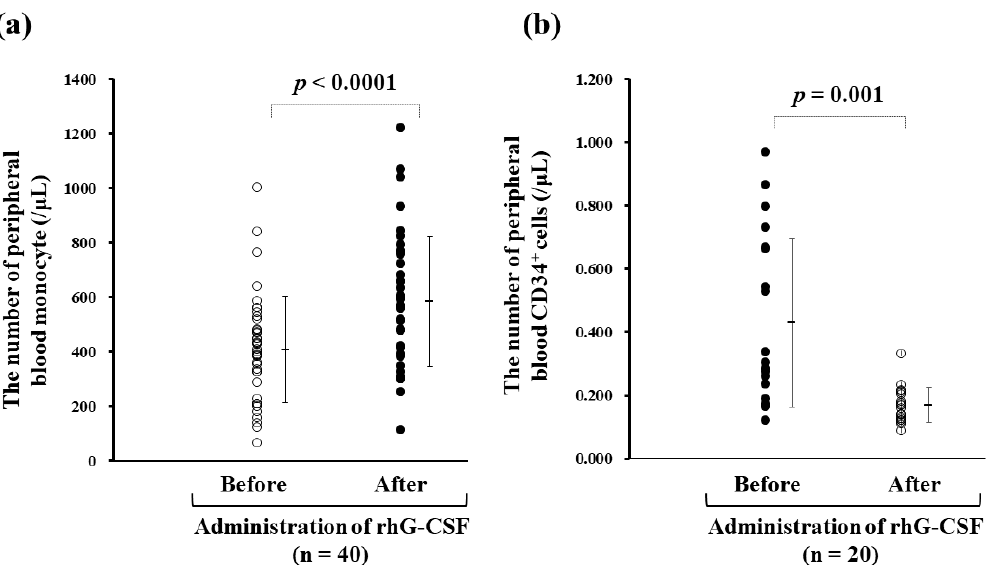
Figure 4. Correlation between peripheral blood monocyte counts before and within 24 h after administration of recombinant human granulocyte colony-stimulating factor (rhG-CSF) (75 µ g filgrastim). ( a ) The peripheral blood monocyte counts before and 16–18 h after administration of rhG-CSF were 410 ± 195 / µ L and 586 ± 238 / µ L (n = 40), respectively, indicating a 1.5-fold increase. ( b ) CD34 + stem cells did not increase 24 h after rhG-CSF administration (before, 0.401 ± 0.273 / µ L; after 0.169 ± 0.056 / µ L ( n = 20).